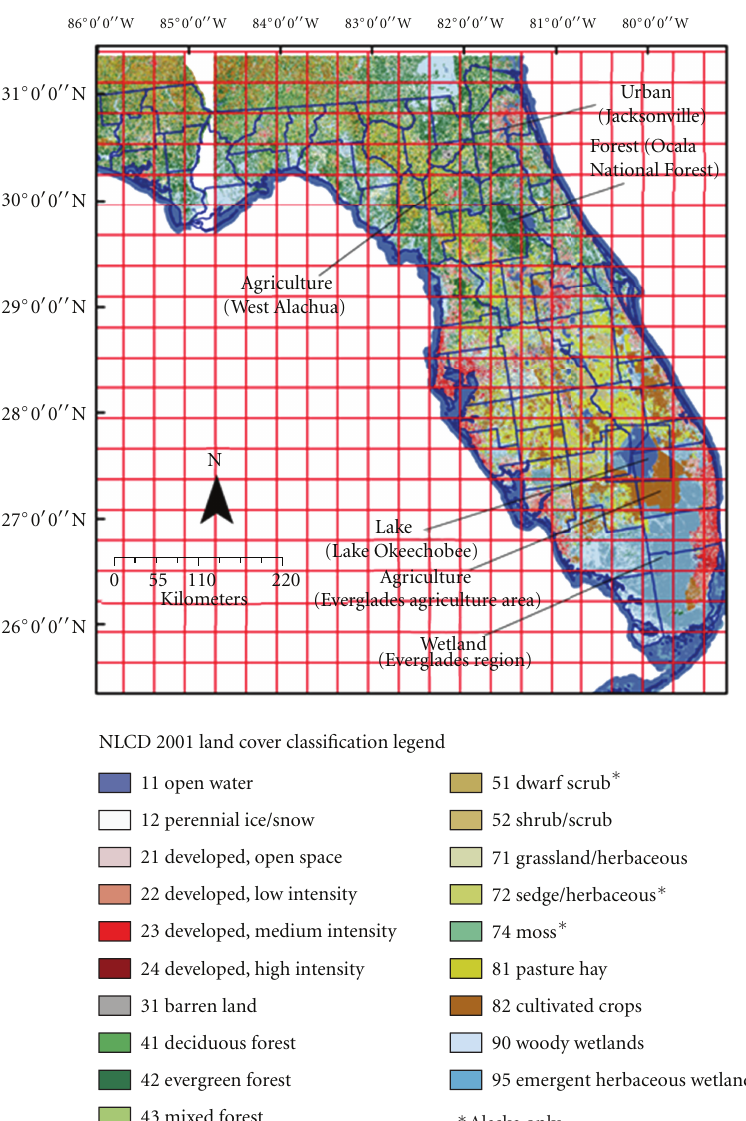
34.5 4 3.5 22.5